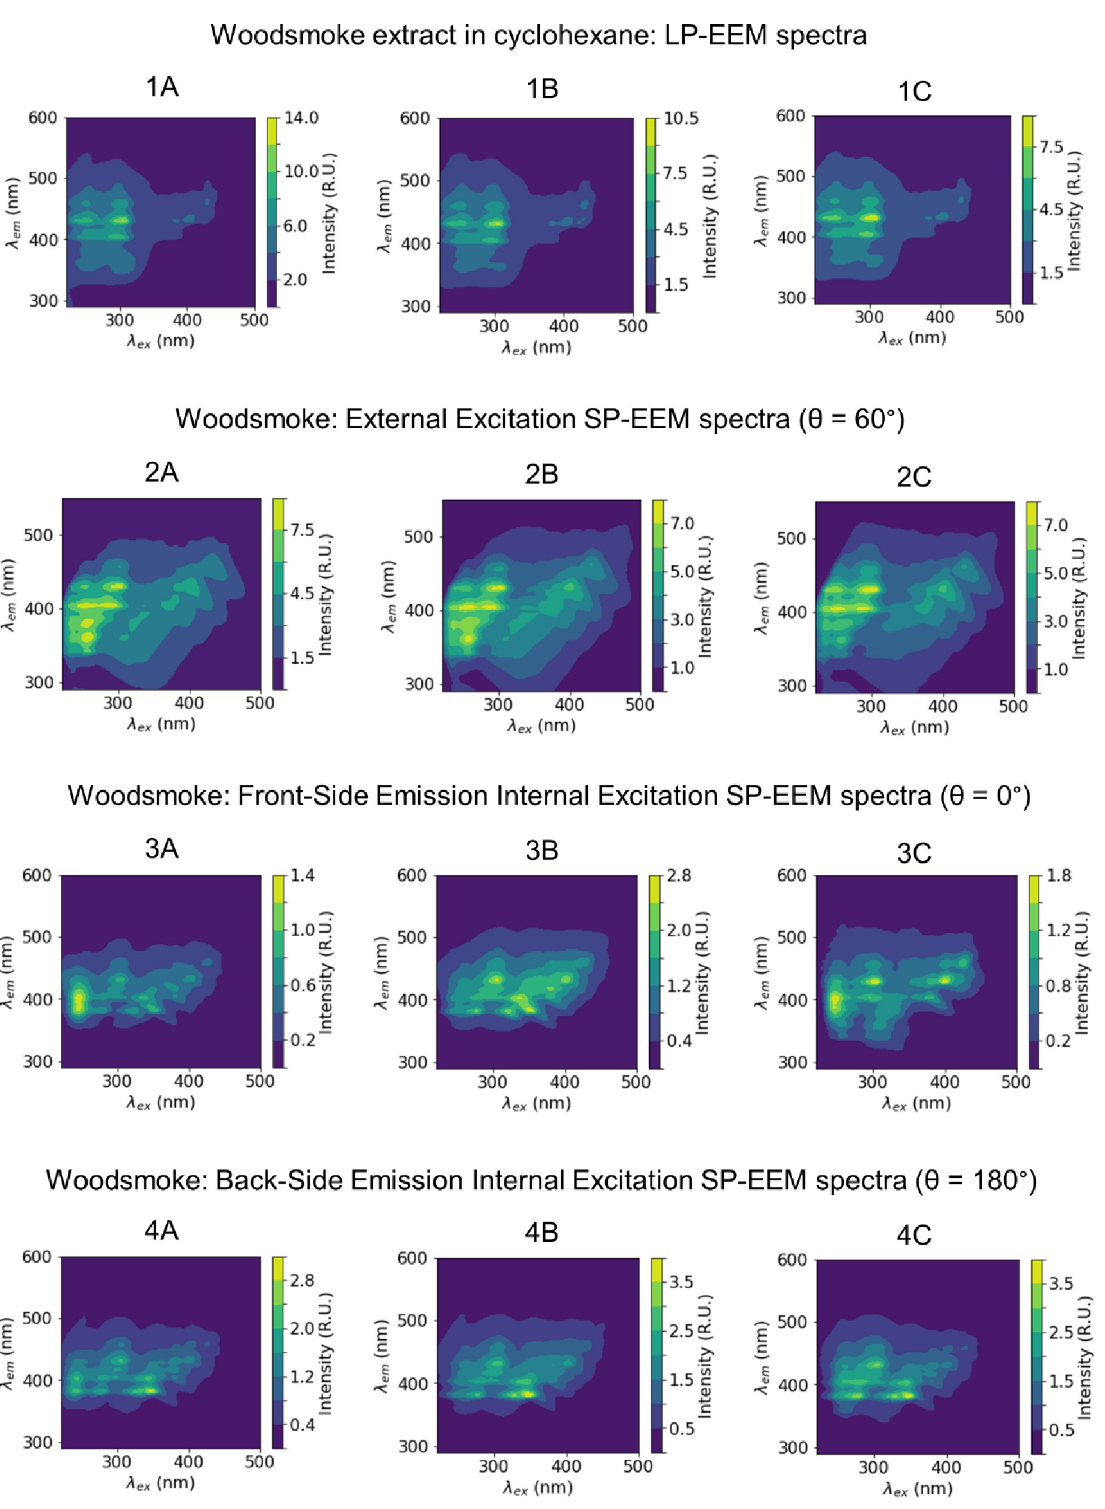
Fig 3. Comparison of SP-EEMs obtained using three different excitation configurations and LP-EEMs for woodsmoke PM. For each optical configuration, three samples (A, B, C) were analyzed. The external excitation SP-EEMs match well with LP-EEMs. Both front-side emission and back-side emission internal excitation SP-EEMs lose spectral information for λ ex < 250nm due to interference of PDMS fluorescence (S5 Fig in S1 File).